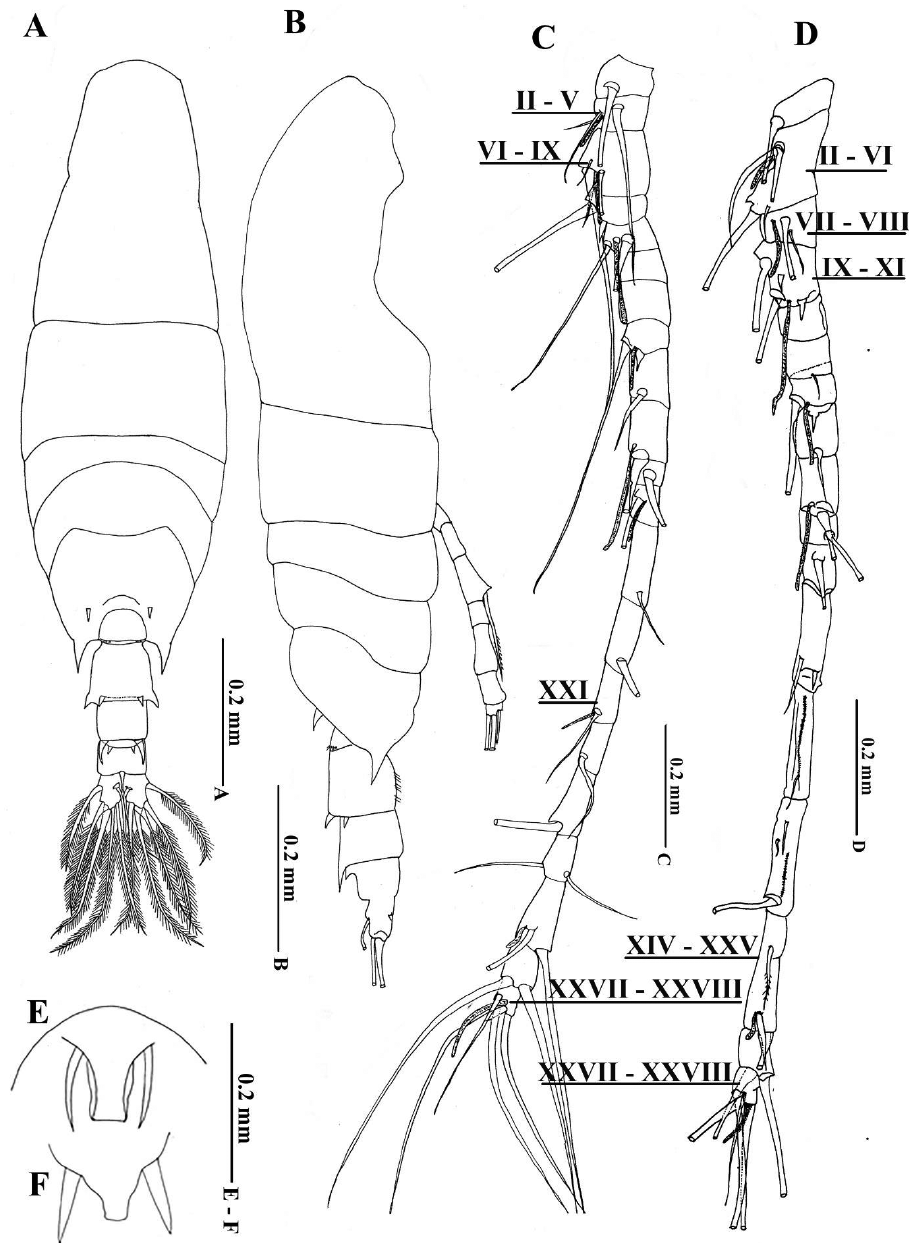
Figure 4. Acartia ( Odontacartia ) edentata sp. n., female ( F ) and male ( A–E ) (allotype) A Habitus, dorsal view B Habitus, lateral view C Antennule, Roman numerals denote segment numbers D Antennule, Ro- man numerals denote segment numbers E Rostrum of male F Rostrum of